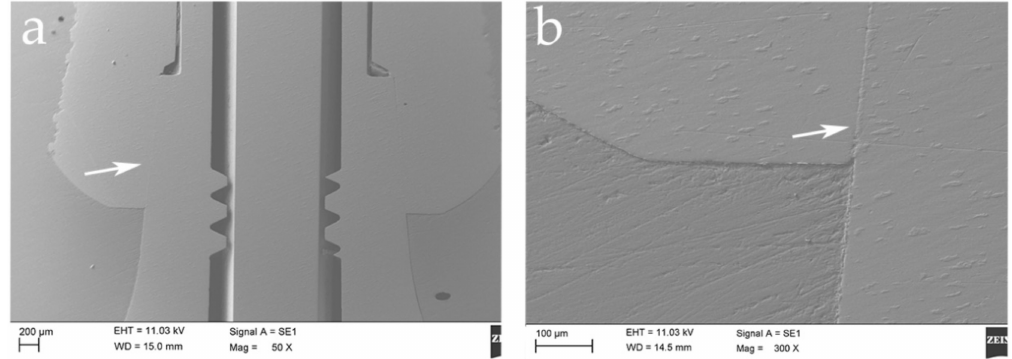
Figure 5. SEM images showed the microgap between implant and abutment, indicated by arrows. ( a ) 50 × magnification and ( b ) 300 ×